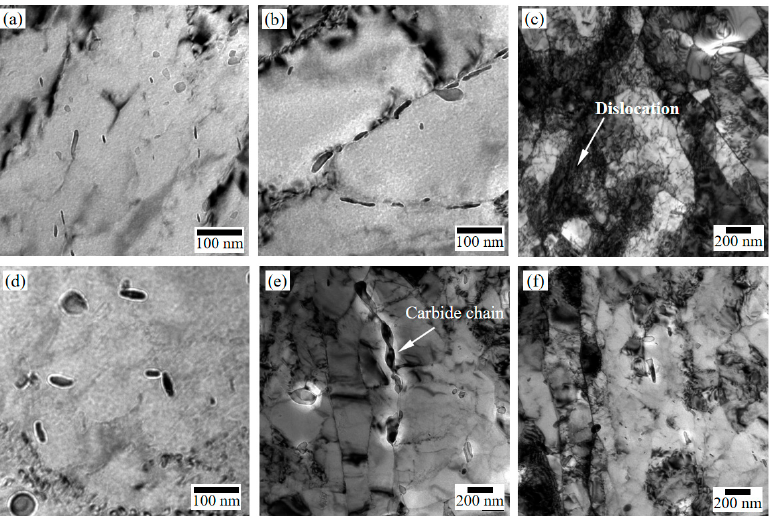
Figure 5. TEM images of the microstructure in the precipitates of the 2.25Cr1Mo0.25V steel in the ( a – c ) NT state and ( d – f ) Max.SPWHT state.